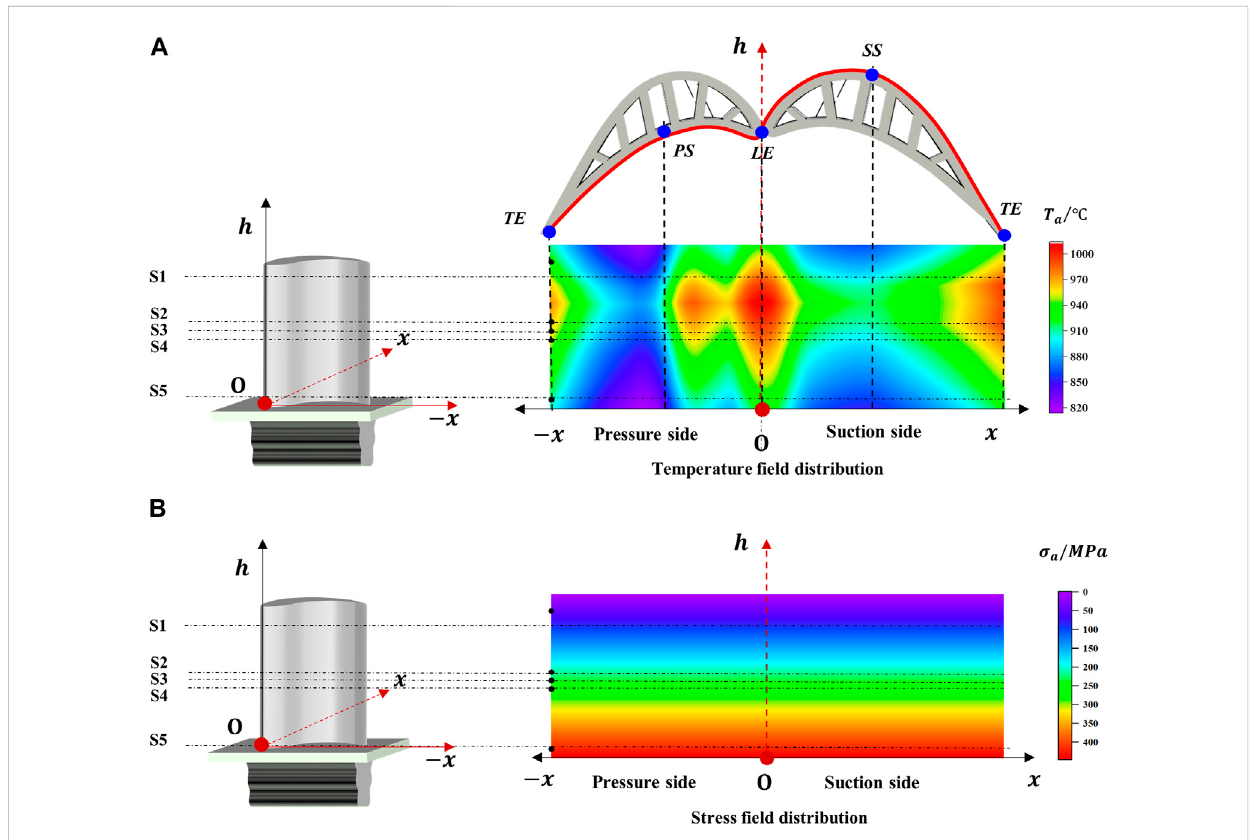
FIGURE 2 Temperature and centrifugal stress pro fi les of the DZ125 blade in service. (A) Temperature distribution of the DZ125 blade wall with fi lm cooling holes and (B) centrifugal tensile stress distribution along the blade height.